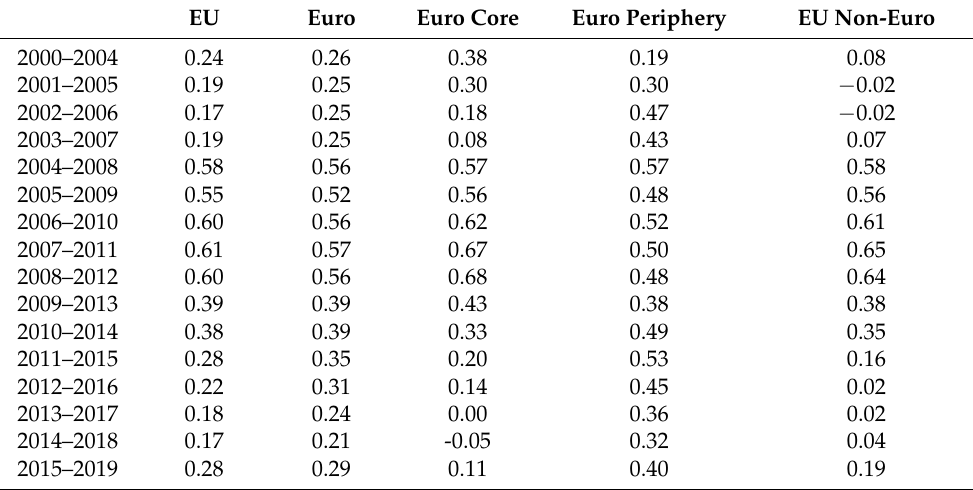
Table 2. Industrial production growth rates—averages of country-level correlation coefficients for different country groups. EU Euro Euro Core Euro Periphery